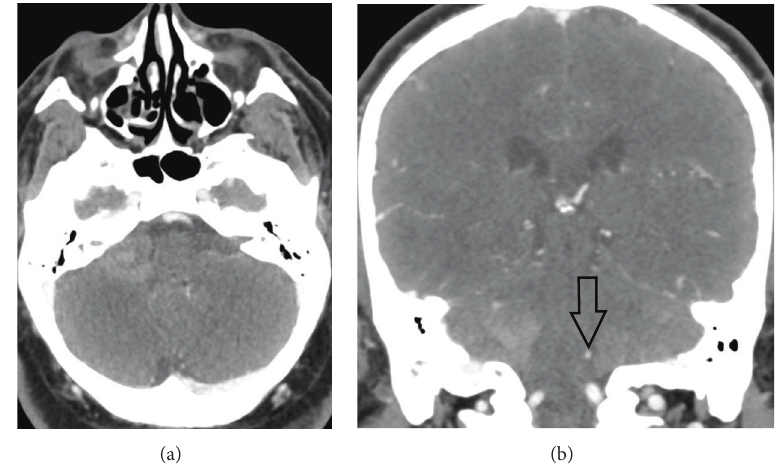
Figure 2: Axial (a) and coronal (b) CT angiography (CTA) of the head in the arterial phase demonstrates unchanged hemorrhage in the region inferior right cerebellar peduncle, likely intraparenchymal, with extension into the fourth ventricle without evidence of aneurysm or vascular malformation. The right posterior inferior cerebellar artery (PICA) is not well seen (arrow in (b) indicates the normal left PICA) and may be compressed by surrounding hemorrhage, involved with vasospasm or